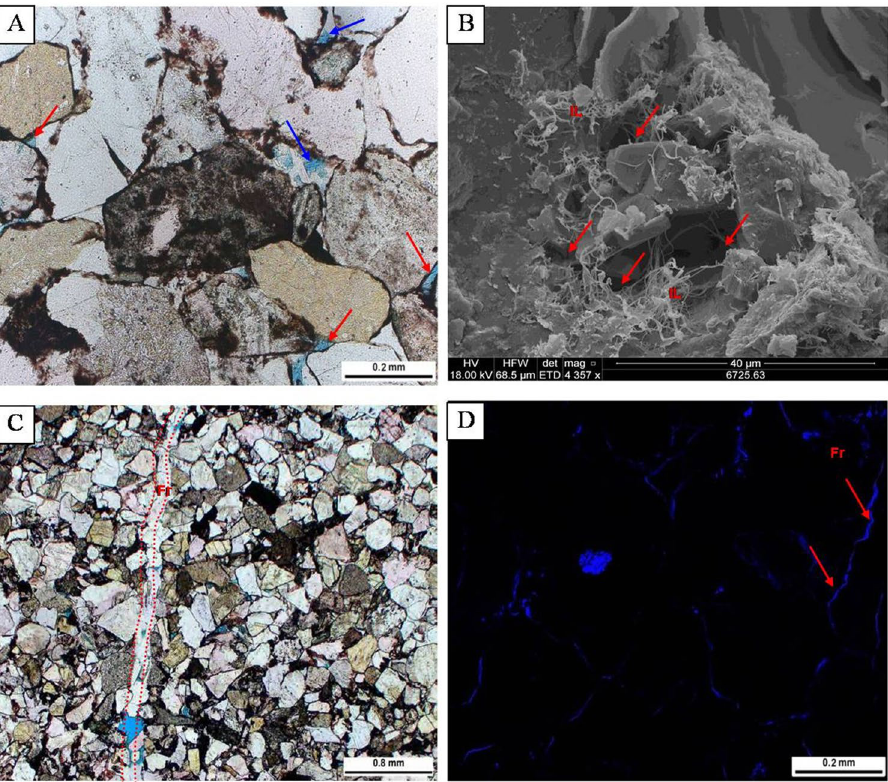
Figure 7. Photomicrographs showing the pore systems of the sandstones. ( A ) Intergranular pores (red arrow) and intragranular pores (blue arrow). ( B ) Miicropores (red arrow) associated with the illite (IL). ( C ) Natural fractures (red dashed lines). ( D ) Fractures (Fr) are